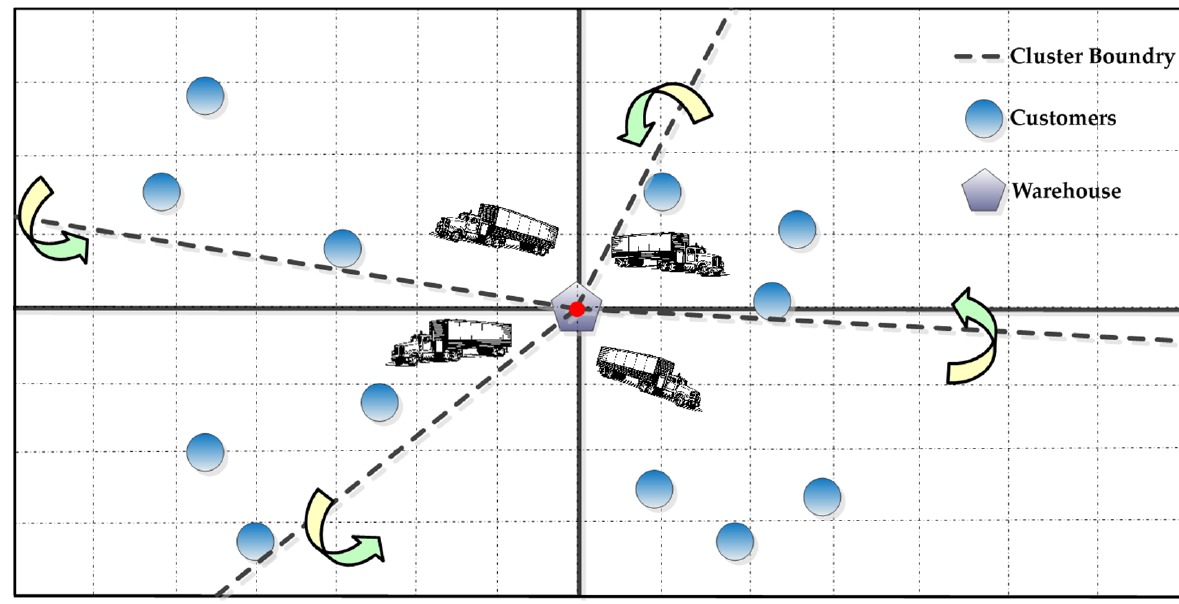
Figure 4. An illustration of clustering by the sweep method. The total cost is accumulated by the fixed cost of vehicles used (operational cost) and transportation costs as vehicles travel from one customer to another. In some cases, the aggregated service time consumed by each customer is also considered. Overall, the shorter the distance traveled by vehicles, the lower the total cost incurred. Figure 5 exemplifies the hierarchies of the proposed two-phase algorithm for 10 customers with homogeneous demand served by 2 vehicles as well as the chromosome encoding format in this